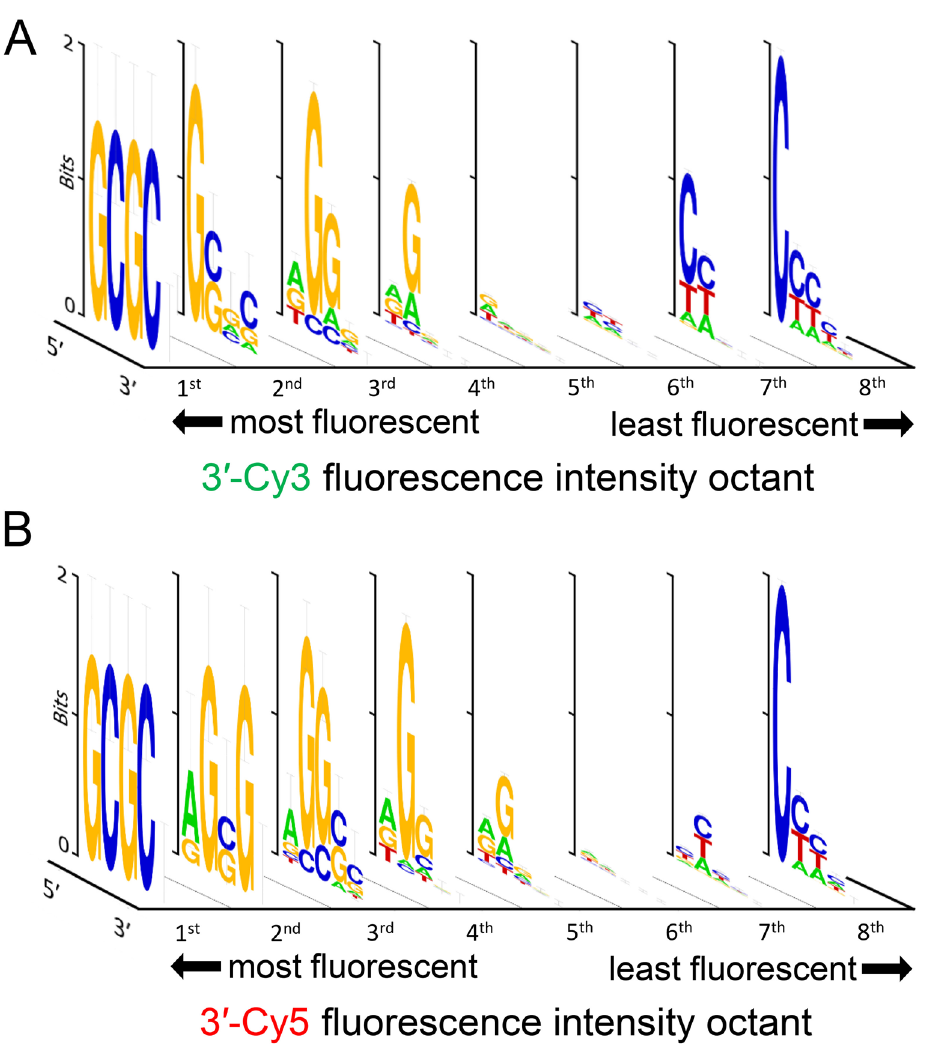
Figure 3. Sequence-dependent variations in the fluorescence intensity of 3 ′ Cy3- and Cy5-labeled single- stranded oligonucleotides. The intensity range in Figure 2 was divided into 8 equal parts from which consensus sequences were generated and the sequence logos for each octile arranged in descending order of fluorescence intensity (left to right), for 3 ′ -Cy3 ( A ) and 3 ′ -Cy5 labeling ( B